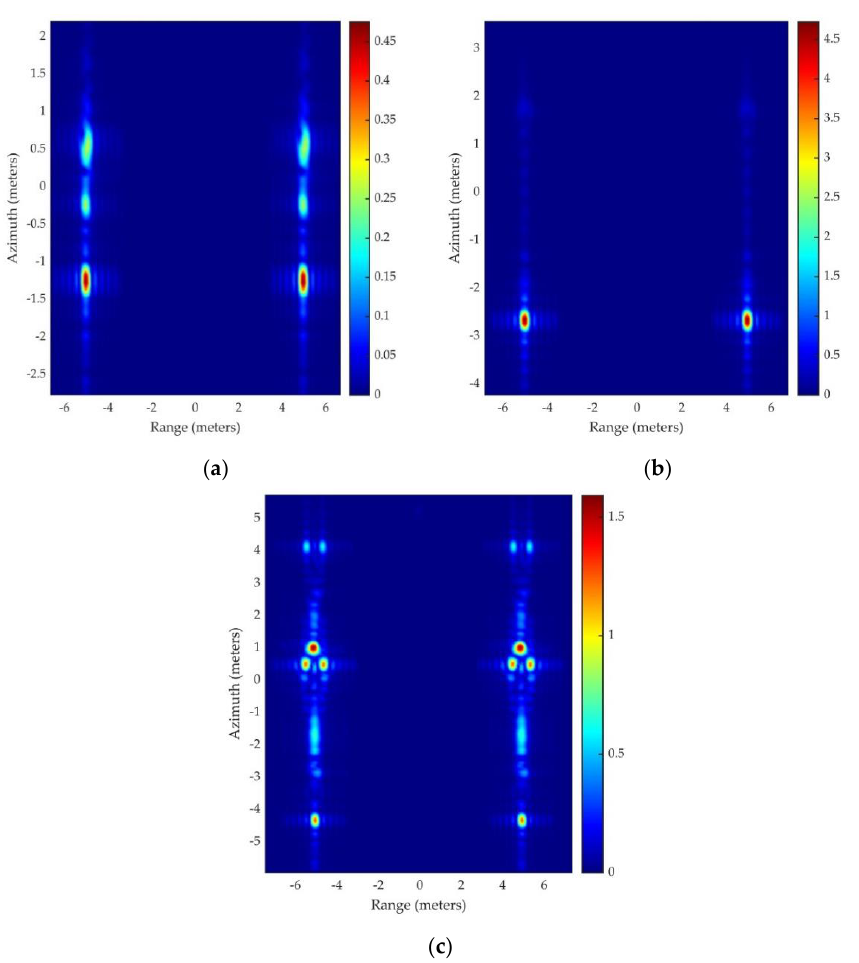
Figure 12. SAR images of different types of missile−like targets: ( a ) Type 1; ( b ) Type 2; ( c ) Type